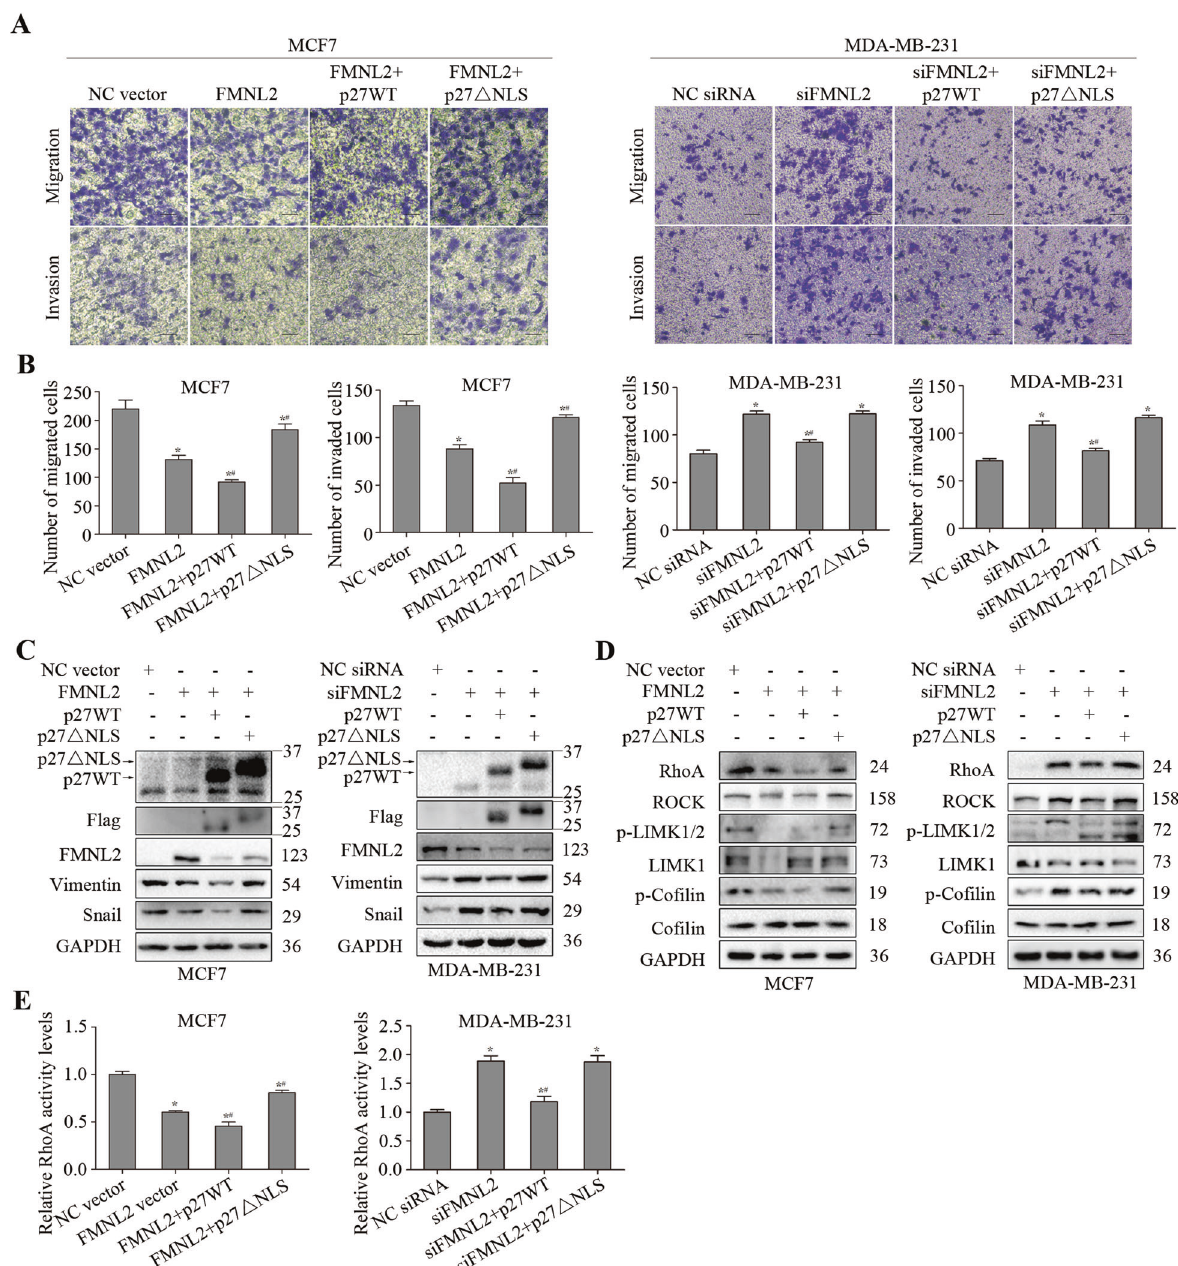
Fig. 4 Effects of cytoplasmic p27 on FMNL2-mediated cell migration and invasion in breast cancer cells. After transfection for 48 h, cultured cells were processed for indicated assays. A, B Representative images and quanti fi ed data of transwell assay were shown. Scale bar, 50 μ m. C The levels of p27, Flag, FMNL2 and invasion-related molecules were examined by western blotting. D The levels of RhoA/LIMK/ Co fi lin-related molecules were examined by western blotting. E The activity levels of RhoA were measured. * P < 0.05 versus NC vector or NC siRNA group, # P < 0.05 versus FMNL2 vector or siFMNL2